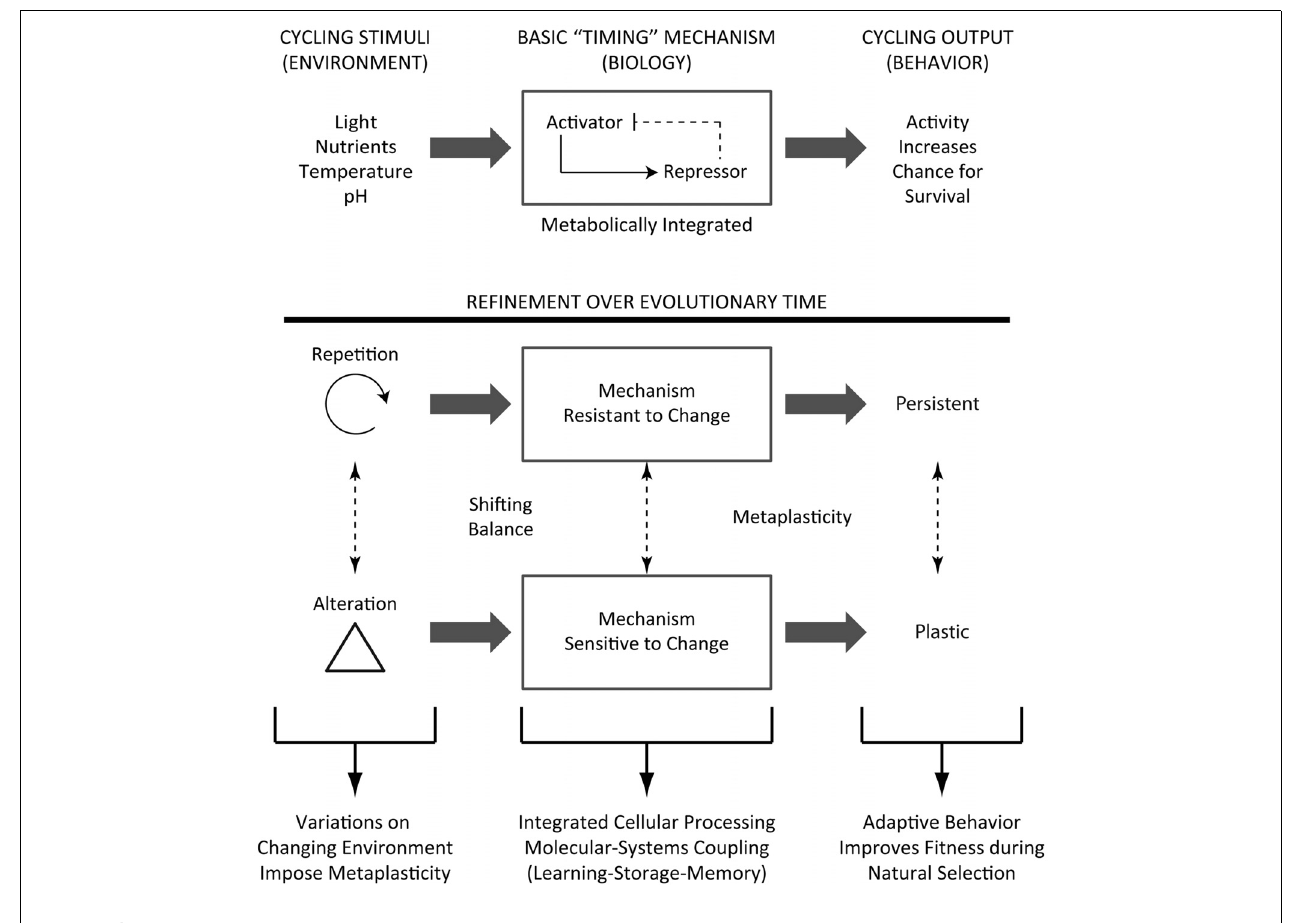
regularly occurring cue (for example, a daily light–dark cycle), the mechanism would continue to persist.This would be evolutionarily advantageous, and permit the organism to place itself in its appropriate niche through memory. This mechanism would necessarily require an adaptive component, since there would be alterations in the environment that would “reset” optimization limits, rendering the system to have a “metaplastic” quality.The metaplasticity of the system instills a scaled learning component balanced against resistance (memory) mechanisms, creating an integrated processor that improves fitness during natural